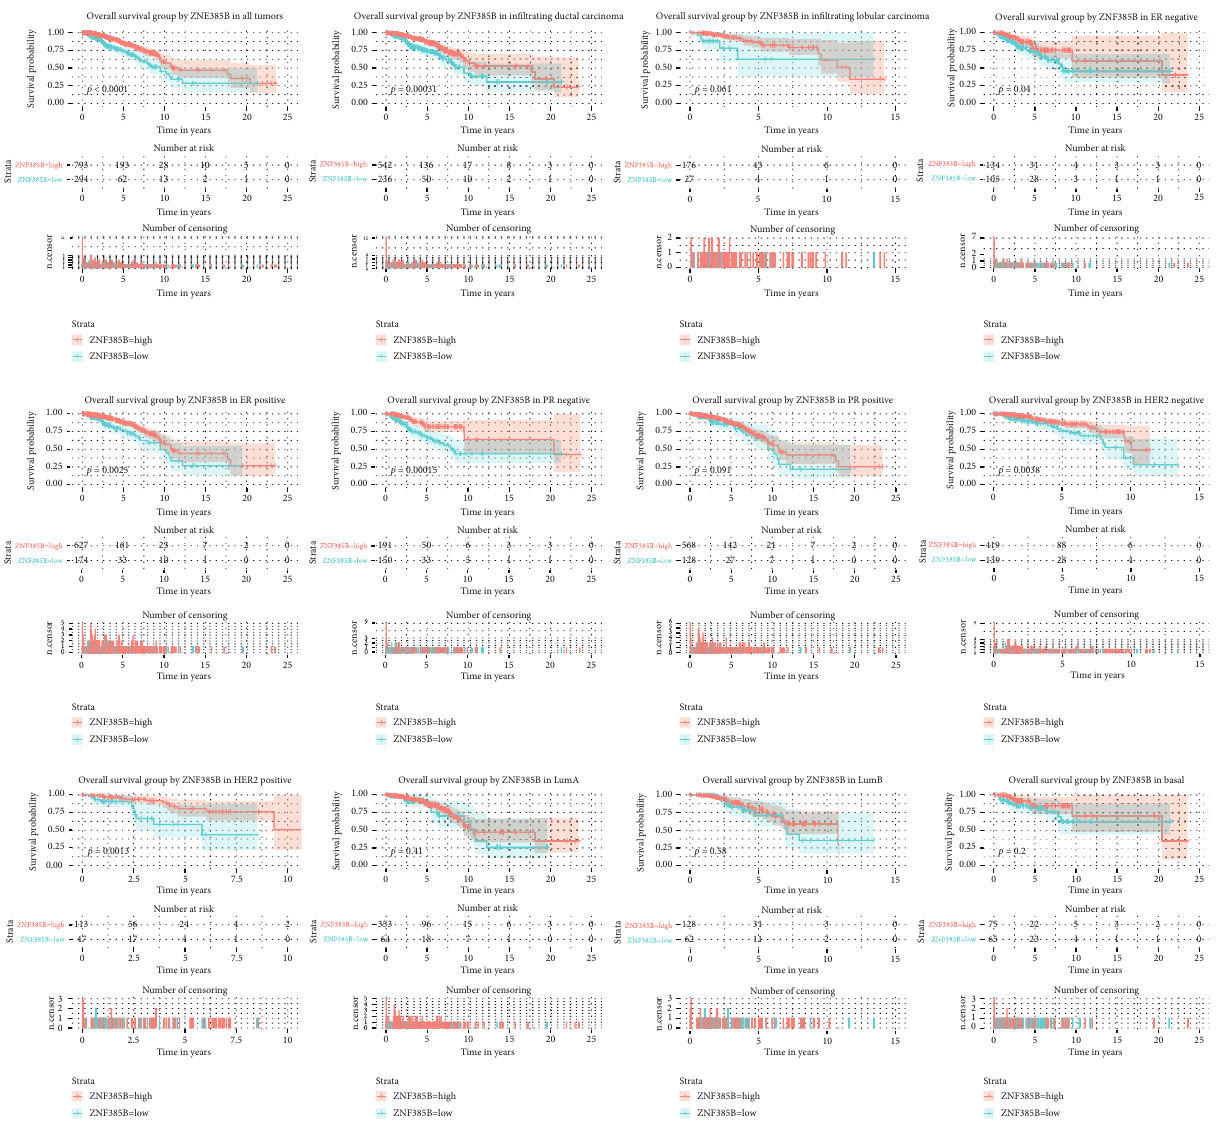
Figure 3: Kaplan-Meier curves of OS in breast cancer. Kaplan-Meier curves for OS in all tumors, di ff erent histological types (in fi ltrating ductal carcinoma and in fi ltrating lobular carcinoma), ER, PR, HER-2, and molecular subtype (LumA, LumB, and